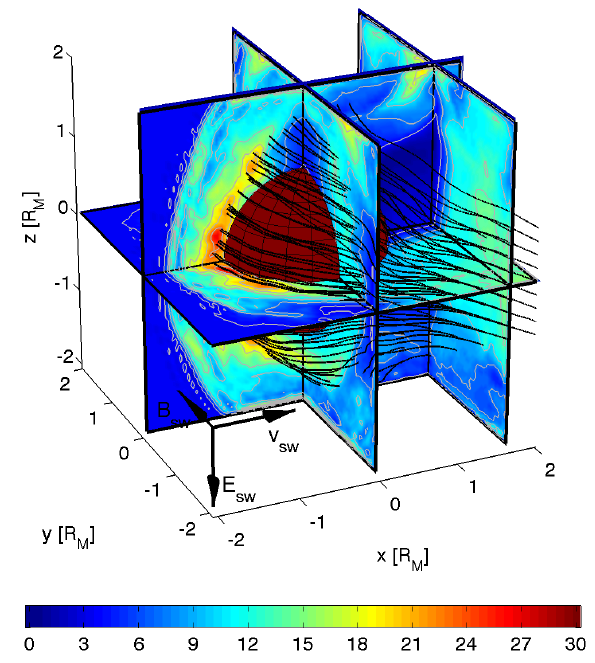
Fig. 8. Simulation results for the “standard run” continued. The cutting planes show the heavy ion density (O + ) in cm − 3 . The black solid lines represent the streamlines of the corresponding ve- locity field. The heavy ions form a complex tail structure behind the planet. Note the boundary on the dayside, where the heavy ion density shows a sharp increase. This is also the case for the upper edge of the ion tail in the E − hemisphere (above the north pole), whereas in the E + hemisphere the boundary is not that pronounced. If one compares this to Fig. 7, the sharply bounded tail fits exactly into the solar wind plasma wake. Hence, both ion species are com- pletely separated. This boundary is the “ion composition boundary” (ICB). Inside the tail the heavy ion density becomes asymmetric, as is seen at the plane x = 5 / 3 R M . The heavy ions form rays inside the tail. The flow pattern is much more asymmetric with respect to the equatorial plane compared to the solar wind flow pattern. Beneath the south pole some cycloidal motion of a large gyroradius can be seen, whereas in the rest of the tail region the stream lines are bun- dled inside the tail rays. Furthermore, a wave-like structure with rather large amplitude is evolved on the dayside at the ICB in the E − hemisphere (north pole). This wave strips off heavy ion plasma clouds with high density. This structure is non-stationary. Parameters: see Fig. 7.